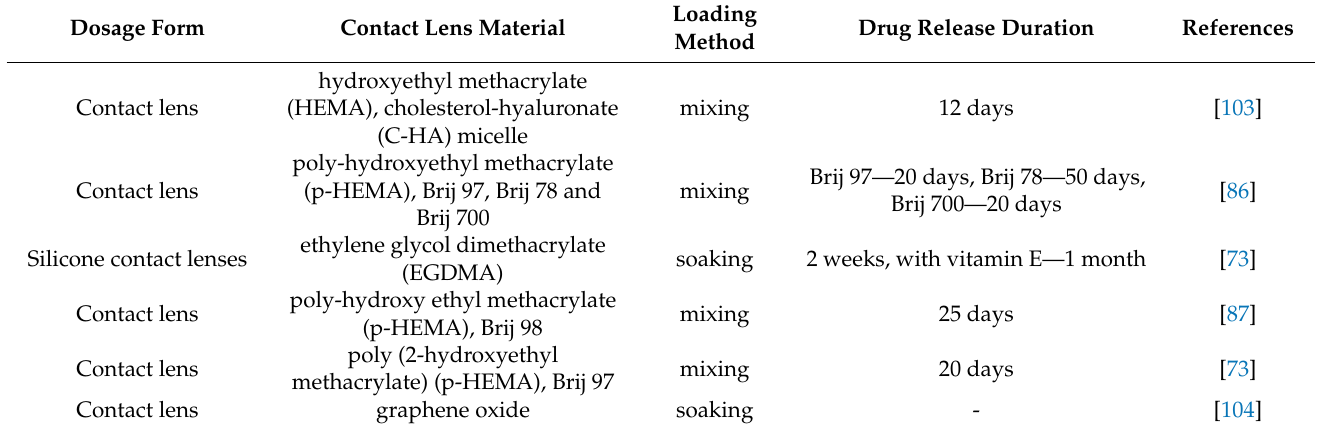
Table 4. CsA delivery from contact lenses for the management of